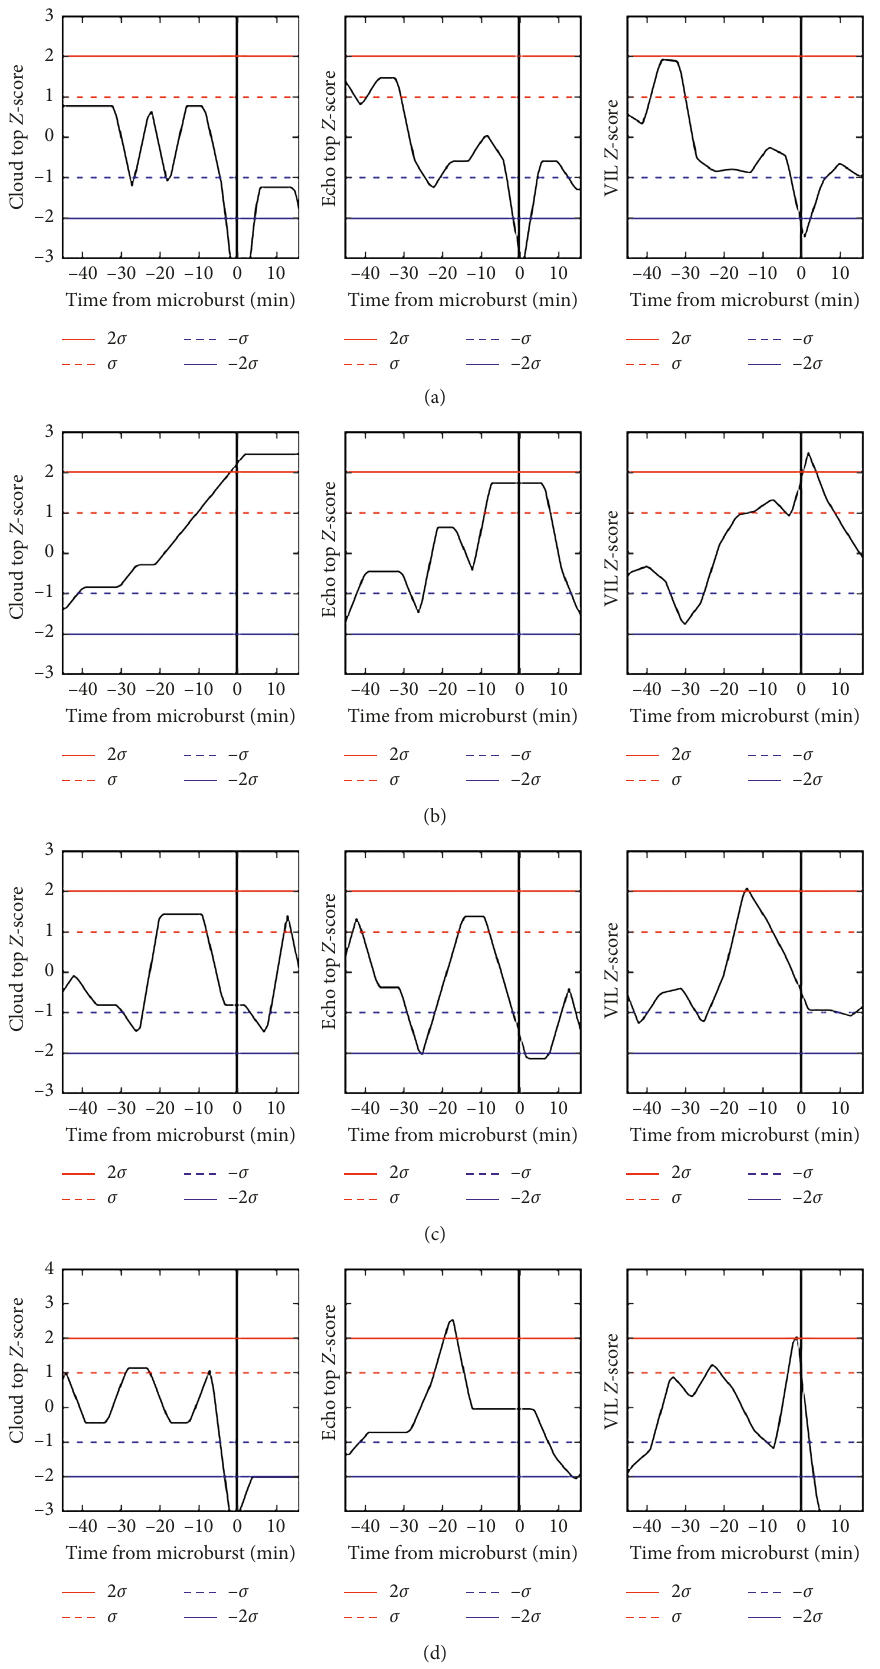
Figure 9: Radar parameters—cloud top, echo top, and VIL—for the first four microburst cases. (a) 20120724 microburst. (b) 20130624 microburst. (c) 20140703 microburst. (d) 20140708NY